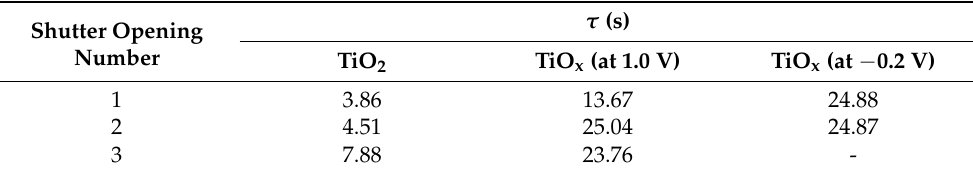
Figure 8. ln D vs. time dependence for the non-reduced and reduced TiO 2 polarized by applying different OCPs. Number in brackets indicates the number of lamp shutter opening. Table 2. Transition state time constant for the non-reduced and reduced TiO 2 polarized at different OCPs for ln D = −